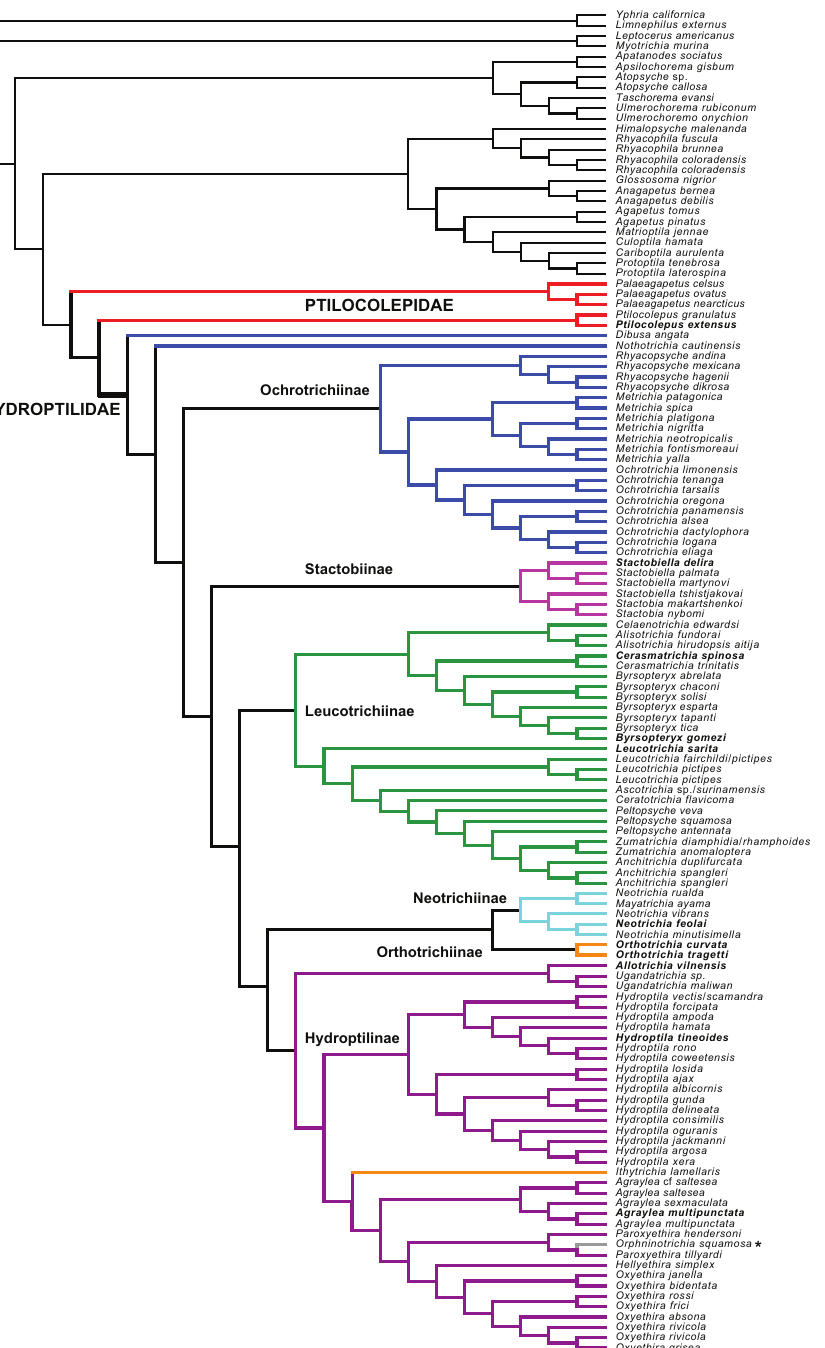
Figure 3. FastRFS majority-rule supertree derived from gene trees generated from both targeted enrich- ment data and Sanger sequencing data. Bold italic font indicates taxa that include targeted enrichment data. * Orphninotrichia , incertae sedis in current